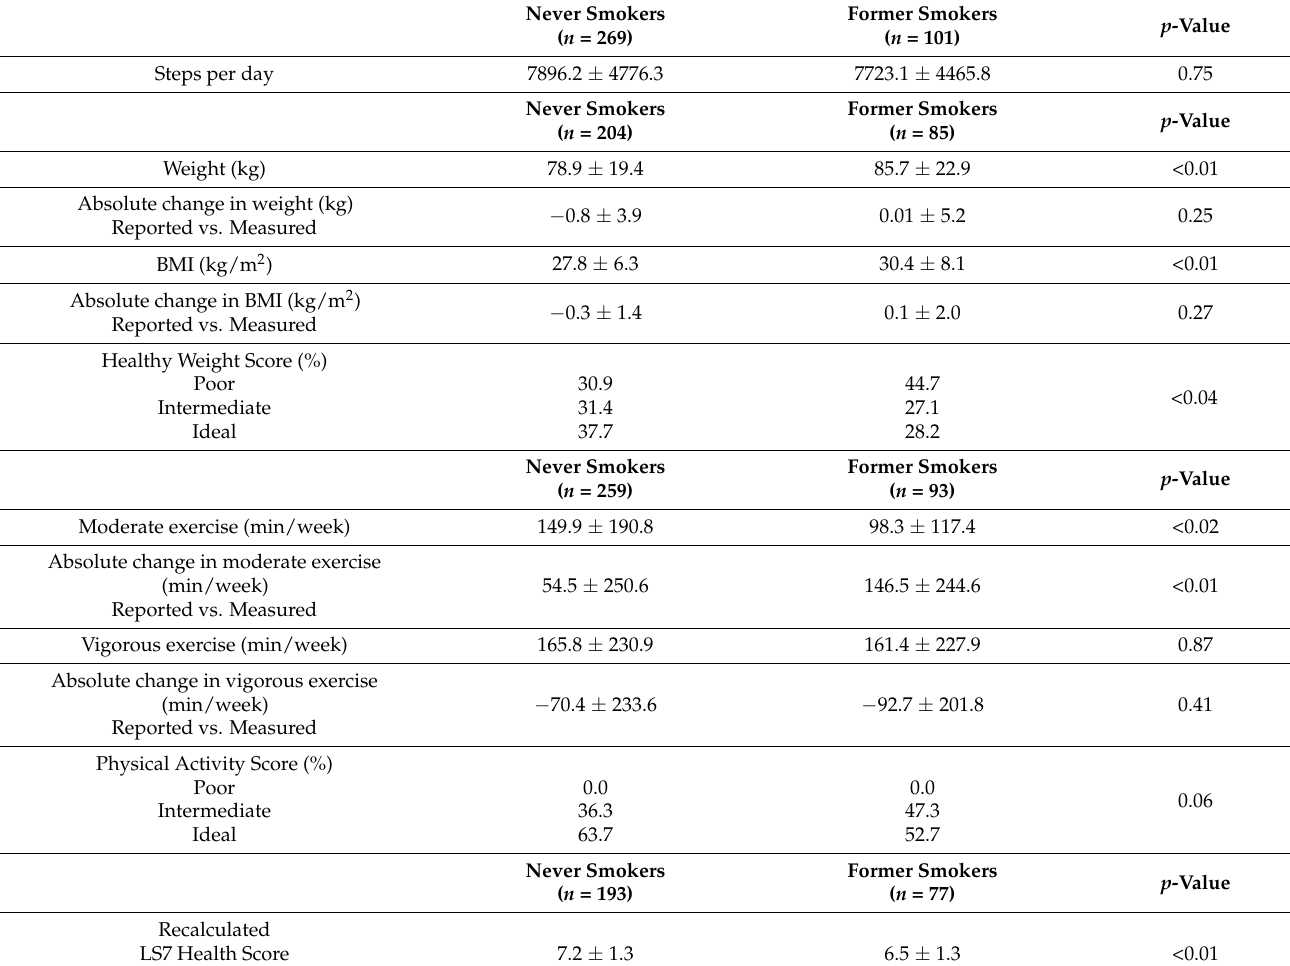
Table 3. Participant digital health device weight and exercise data